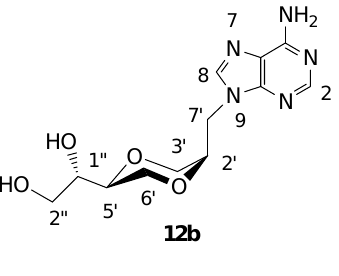
Figure 10. Structure 12b